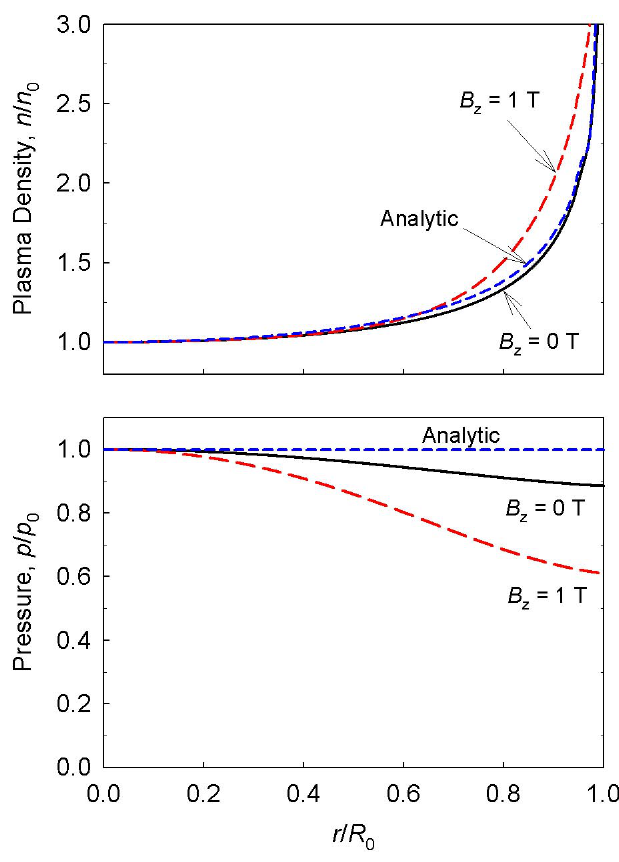
FIG. 4. (Color) Quasistatic model predictions for on-axis tem- perature versus capillary discharge current with R (cid:7) 4 (cid:6) 10 16 cm (cid:3) 3 . B and n 0